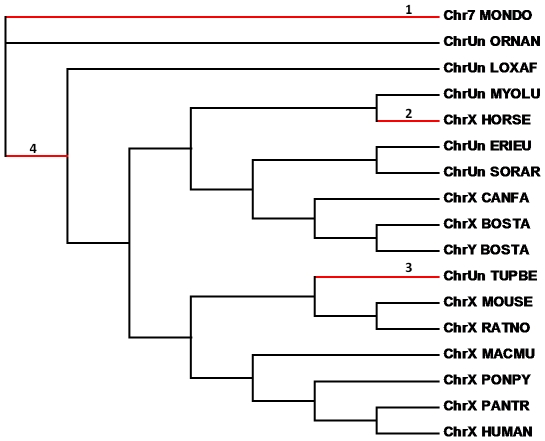
Selection pressures on the mammalian OFD1.Four branches of the mammalian OFD1 tree were identified to be under positive selection (numbered and highlighted in red). The detected sites along each branch are detailed in Table S4.